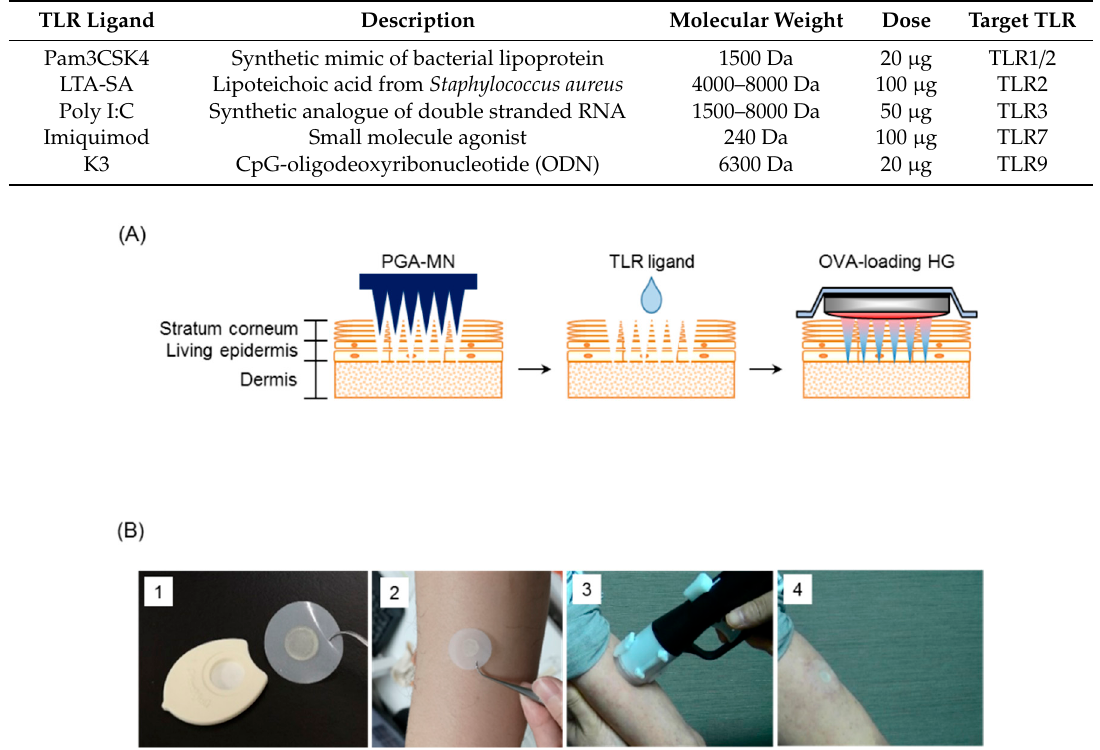
Figure 1. Methods for epicutaneous immunization in mice and humans. Puncture holes were made on the hairless back skin of mice using biodegradable polyglycolic acid-microneedle (PGA-MN). A 5- µ L volume of toll-like receptor (TLR) ligand and OVA-loaded hydrophilic gel patch (HG) were applied to the holes ( A ). In human subjects, (1) K3 (200 μ g)-loading self-dissolving microneedle (sdMN) and placebo-sdMN were fixed to the plastic case that (2) was placed on the skin of the lateral upper arm and (3) applied with a handheld spring-type applicator that was (4) attached for an hour ( B ).